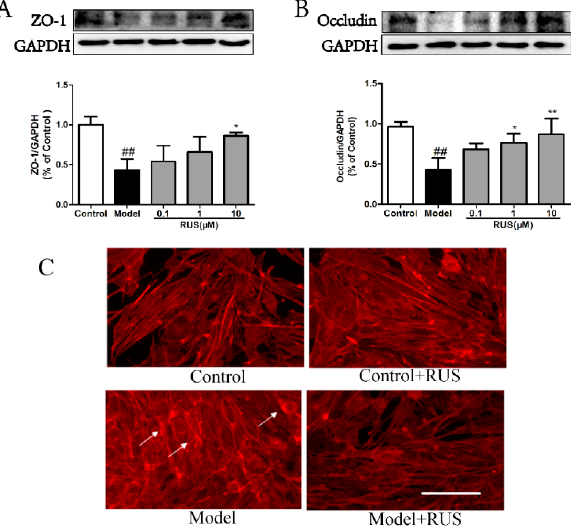
Figure 6. Effects of ruscogenin on the expression of tight junction proteins and actin cytoskeleton rearrangement in bEnd.3 cells subjected to OGD/R. ( A , B ) Representative Western blot bands and quantitative analysis of the expression levels of ZO-1 and occludin in different groups. The band intensities were measured using scanning densitometry. The data were normalized to GAPDH expression ( n = 3). The data are expressed as means ± SD. ## p < 0.01 ν s. Control, * p < 0.05, ** p < 0.01 ν s. Model; ( C ) representative immunostaining of F-actin in different groups in bEnd.3 cells subjected to OGD/R; the white arrow indicates the stress fiber. Scale bars = 100 µm.